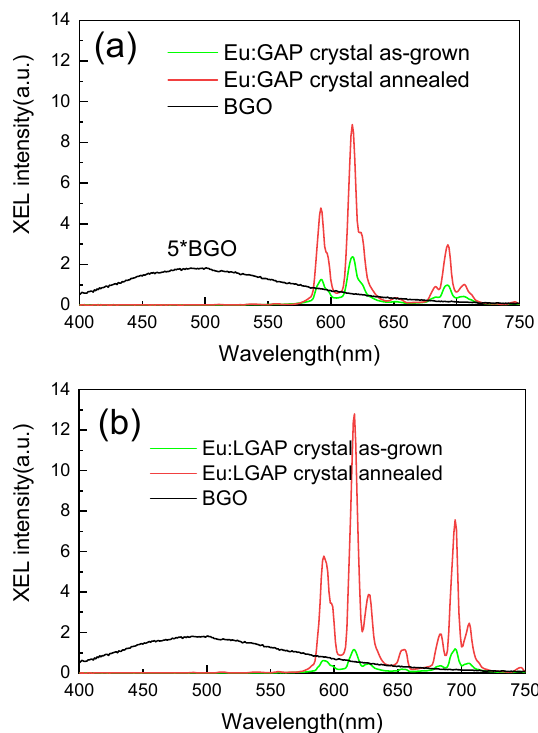
Figure 9. XEL spectra of ( a ) Eu:GAP and ( b ) Eu:GLAP crystals, with or without the 1000 ◦ C for 4 h in Ar + 5% H 2 annealing process. Five times the XEL intensity of a BGO single crystal was used for quantitative